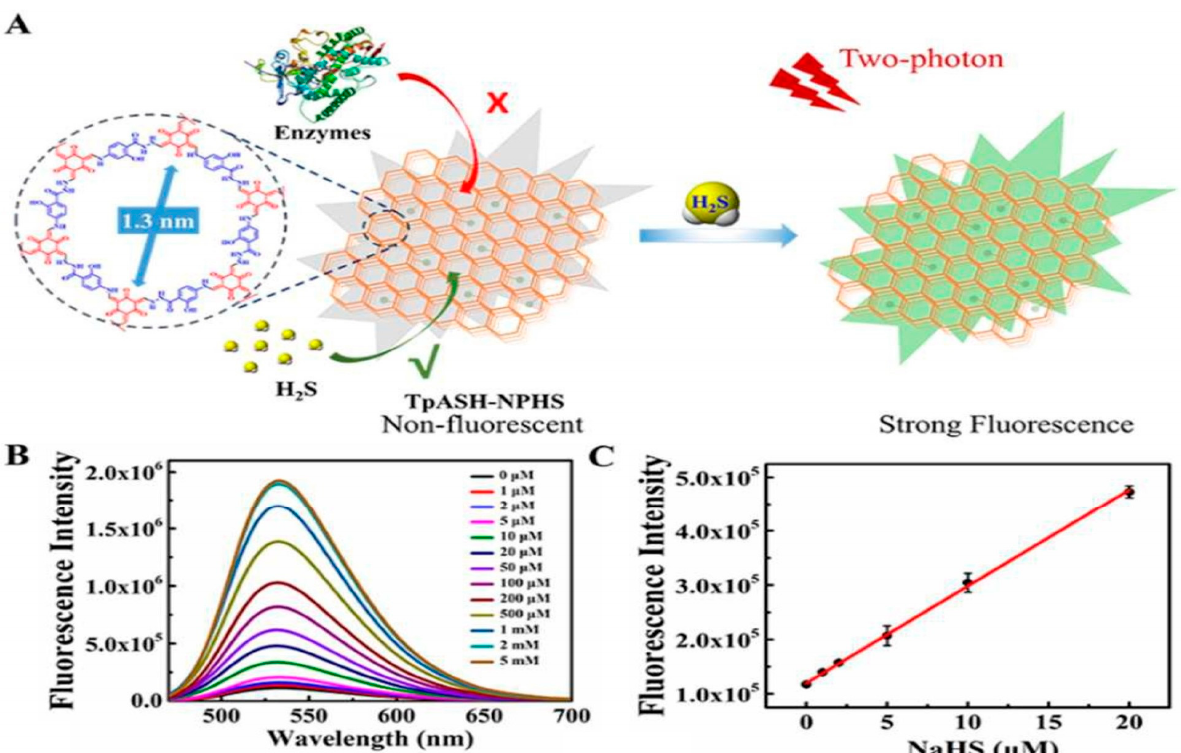
Figure 11. ( A ) H 2 S action on TpASH-NPHS; ( B , C ) fluorescence intensity at different concentrations and the correlation curve [50].